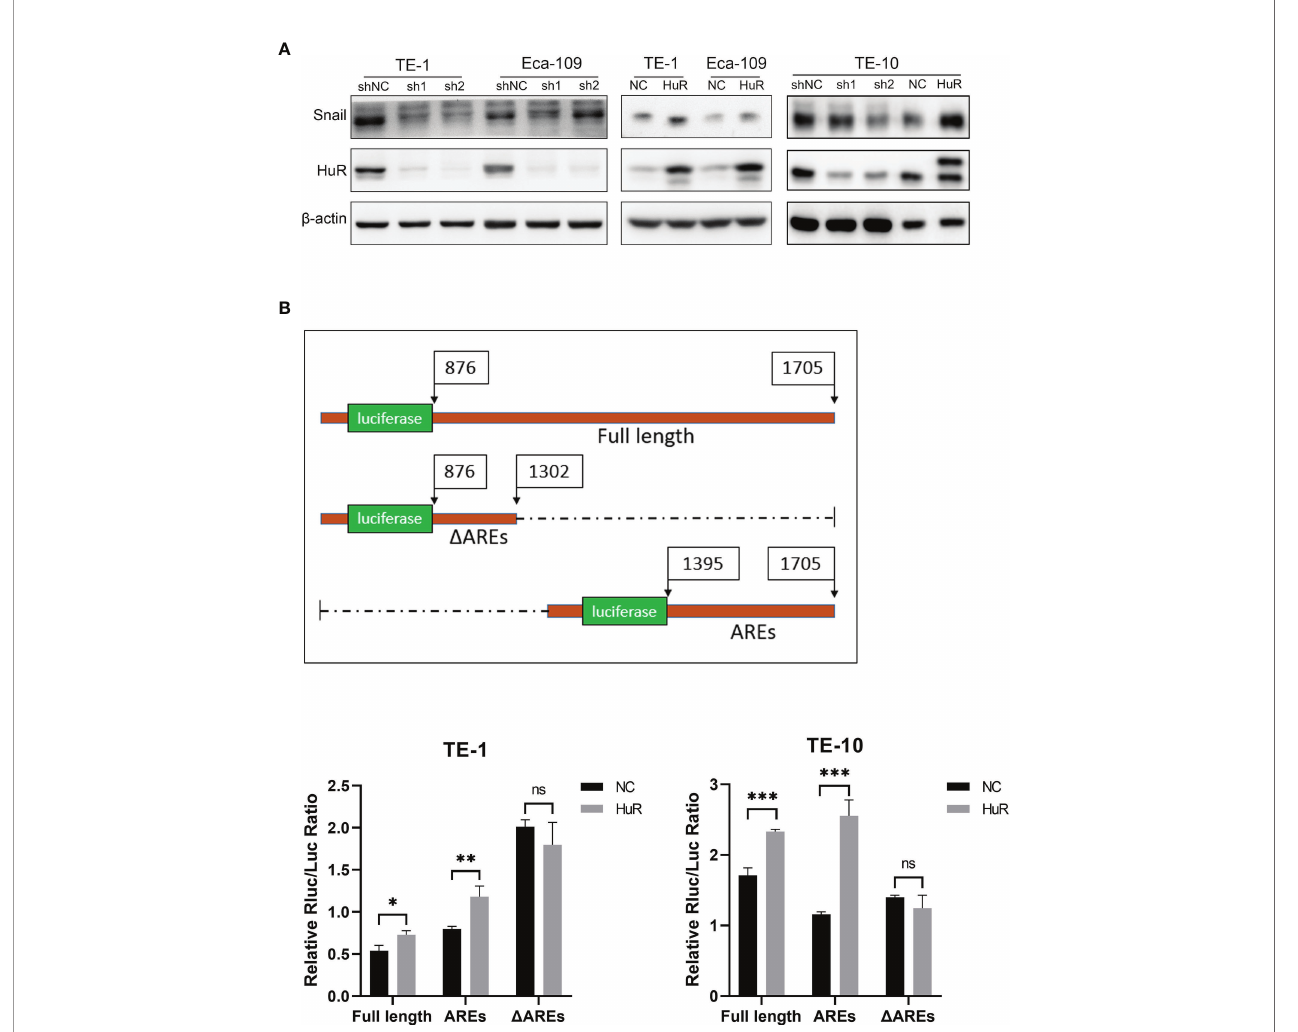
FIGURE 5 | HuR positively regulated the expression of Snail in esophageal cancer cells. (A) Western blot was used to evaluate the expression of Snail in esophageal cancer cells in which HuR was downregulated or upregulated. (B) Schematic diagram of the constructions of the full length and 2 truncations of 3 ’ -UTR of Snail mRNA into the dual-luciferase reporter. TE-1 and TE-10 cell lines were co-transfected with HuR (or vector) and the dual-luciferase reporter with Snail 3 ’ -UTR constructions (either the Full length, AREs or D AREs, or empty reporter). After 48-hour incubation, luciferase activity was measured using the Dual-Luciferase Reporter Assay System (Promega). ns > 0.05, *p < 0.05, **p < 0.01 and ***p <